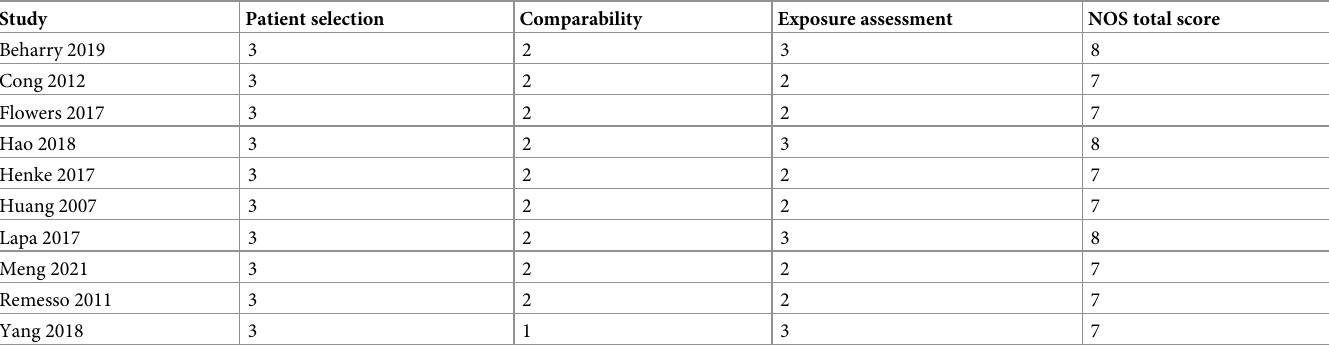
Table 2. The NOS score of included